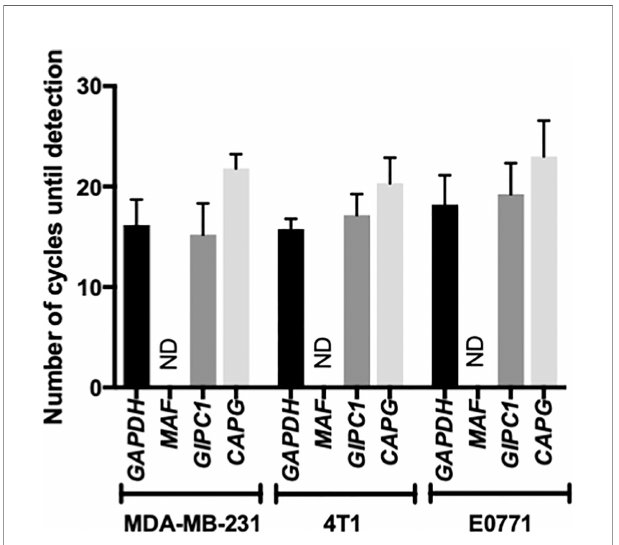
FIGURE 5 | Musculoaponeurotic fi brosarcoma ( MAF ), PDZ domain containing protein GIPC1 ( GIPC1 ), and macrophage capping protein ( CAPG ) gene expression pro fi les in human and mouse bone homing cell lines. Bone homing variants of MDA-MB-231, 4T1, and E0771 cells used in this project were tested for expression of MAF , GIPC1 , and CAPG , along with the housekeeping gene glyceraldehyde 3-phosphate dehydrogenase ( GAPDH ) by real-time QPCR. Data shown are mean ± SEM for three repeats of experiments carried out in duplicate. ND, Not